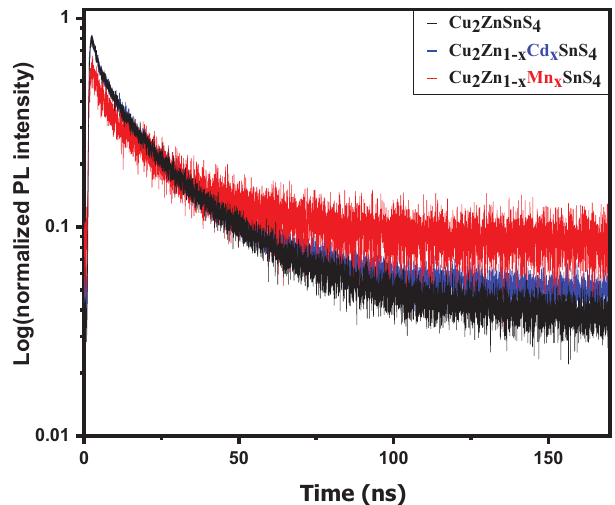
Fig. 10. Normalized and time-resolved photoluminescence decay with excitation wavelengths of 488 nm. Black color CZTS/CdS, blue color CCZTS/CdS and red color